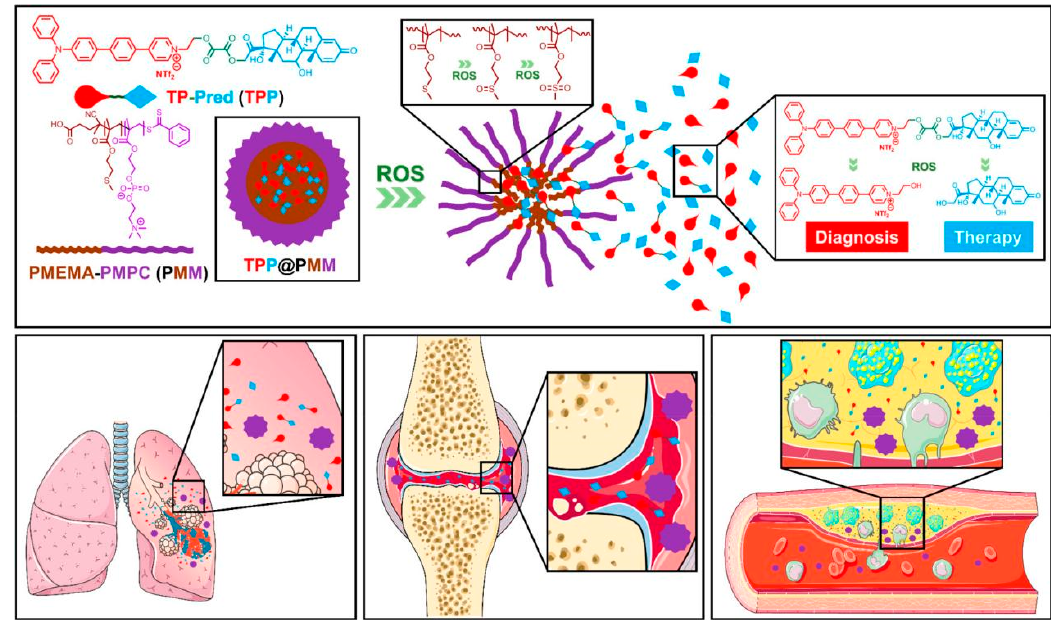
Figure 8. Illustration of the NPs with two-photon imaging and serial ROS sensitivity. Reprinted with permission from ACS nano. Ma, B., et al., Reactive Oxygen Species Responsive Theranostic Nanoplatform for for Two-Photon Aggregation- Induced Emission Imaging and Therapy of Acute and Chronic Inflammation, pages 5862–5873. Copyright 2020 American Chemical Society [53].